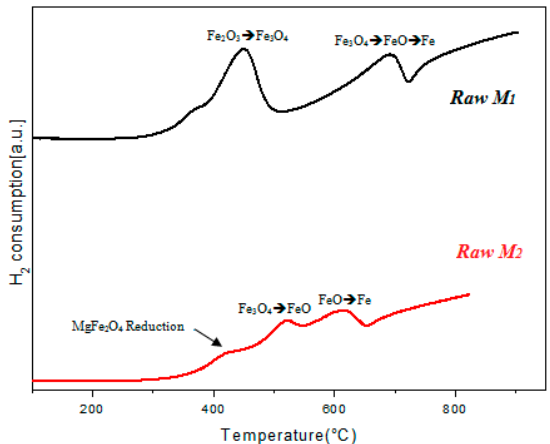
Figure 5. Temperature programmed reduction (H 2 -TPR) profiles for raw materials M 1 and M 2 .